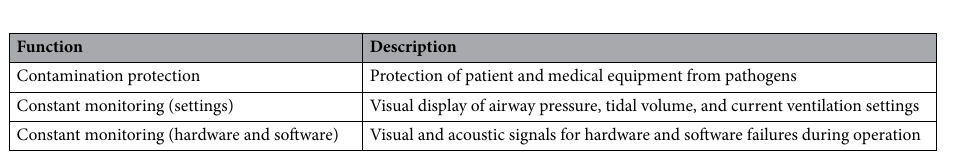
Table 2. Design requirements for CARL to ensure the patient’s safety during ventilation.